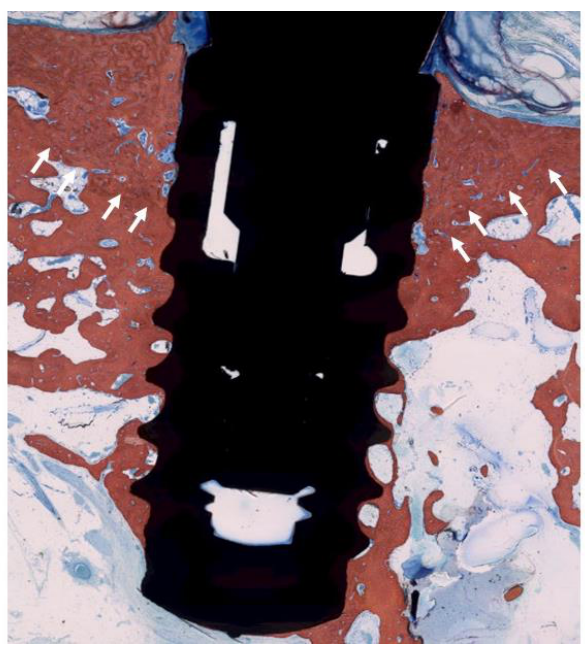
Figure 5. Histologic evaluation of healing after electrolytic cleaning (EC) (SLA ® surface). The arrows indicate the bony crest before treatment. Complete coverage of the formerly exposed implant surface was achieved.